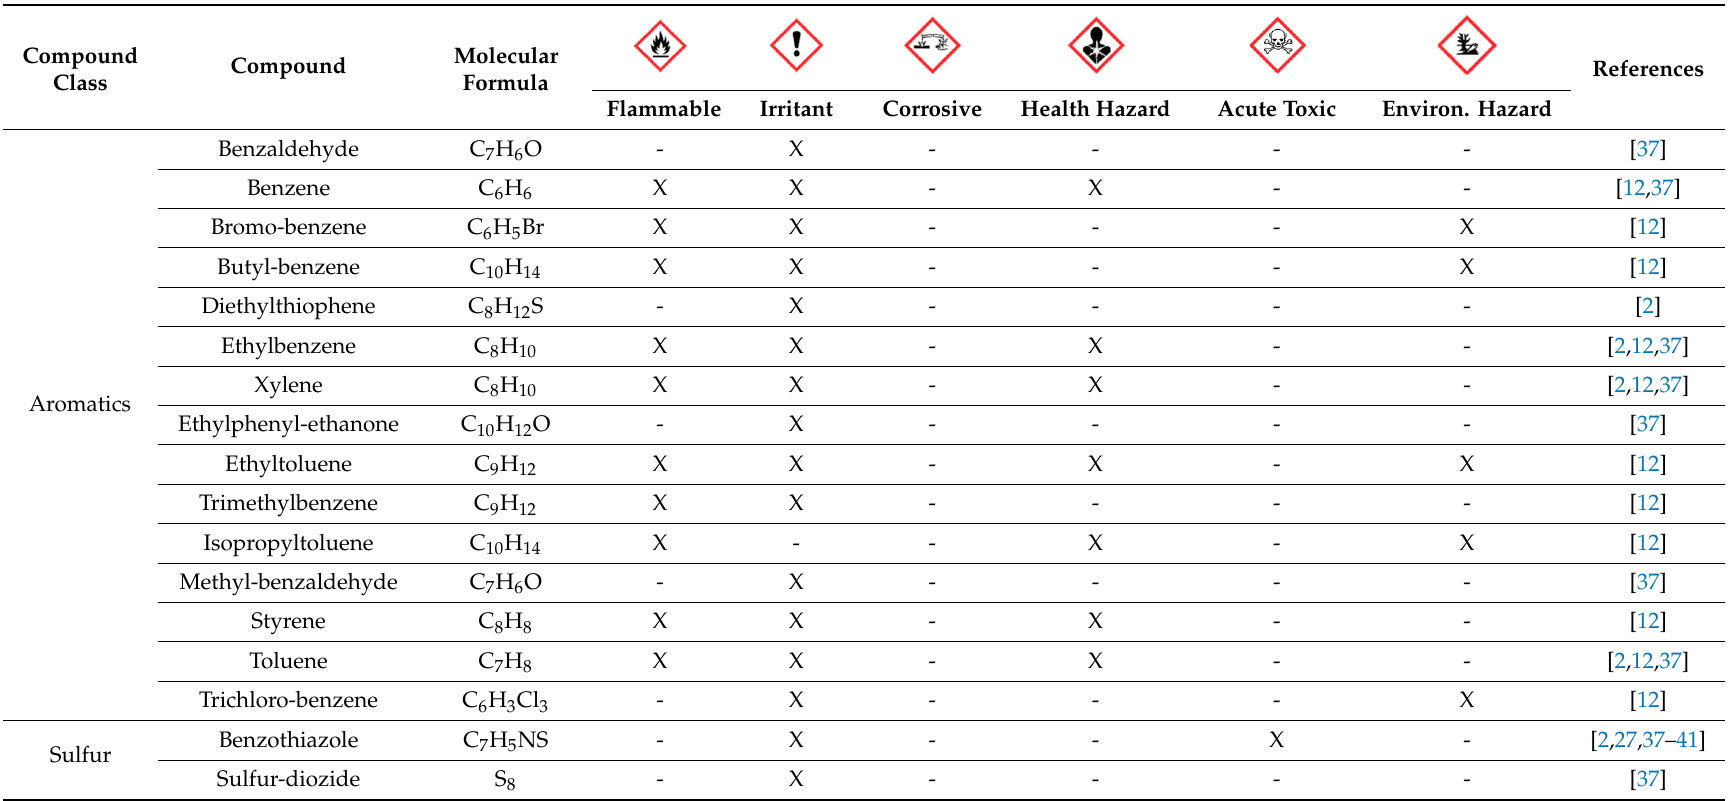
Table 2. List of VOCs identified by proton-transfer reaction time-of-flight mass spectrometer (PTR-TOF-MS) in bitumen samples. The VOCs are classified for their hazardous potential according to the Globally Harmonized System of Classification and Labeling of Chemicals (GHS) [36] .